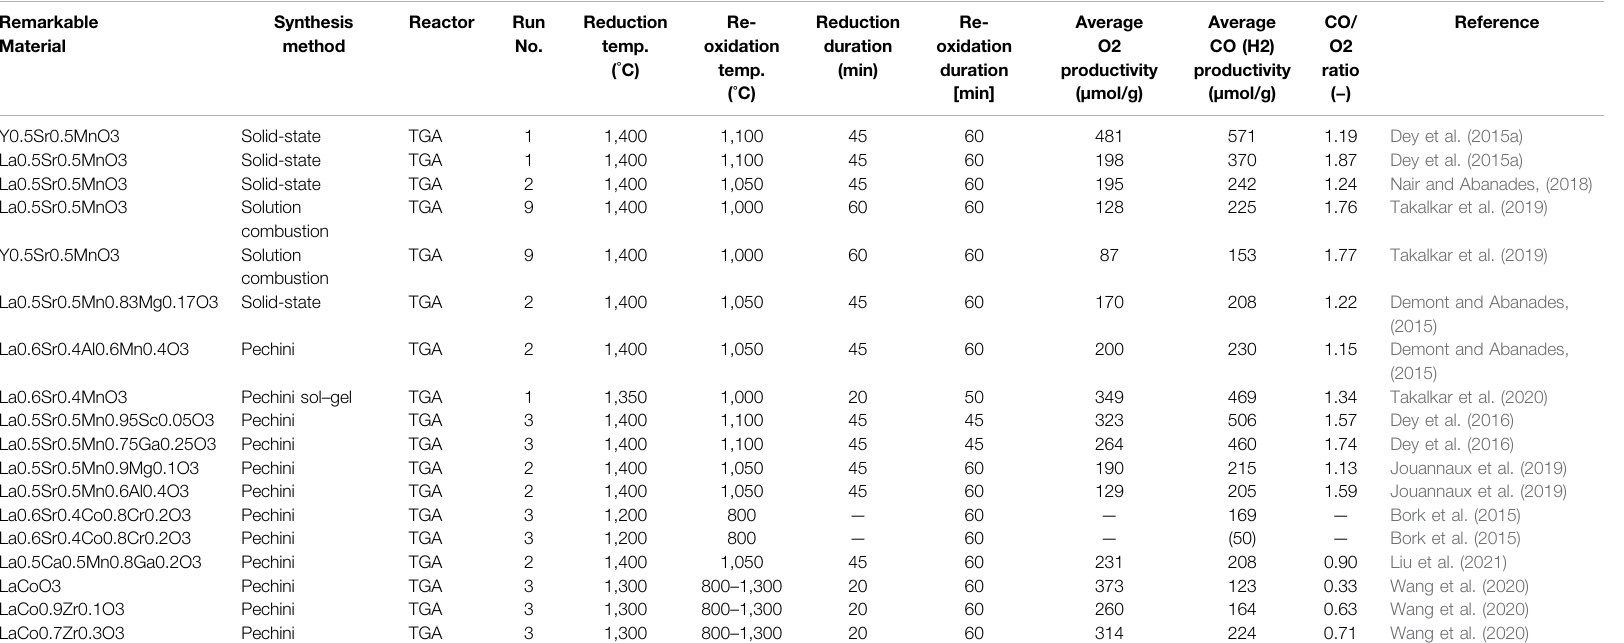
TABLE 1 | List of redox performances and reaction conditions for two-step thermochemical cycles using perovskites in previous literatures. Remarkable